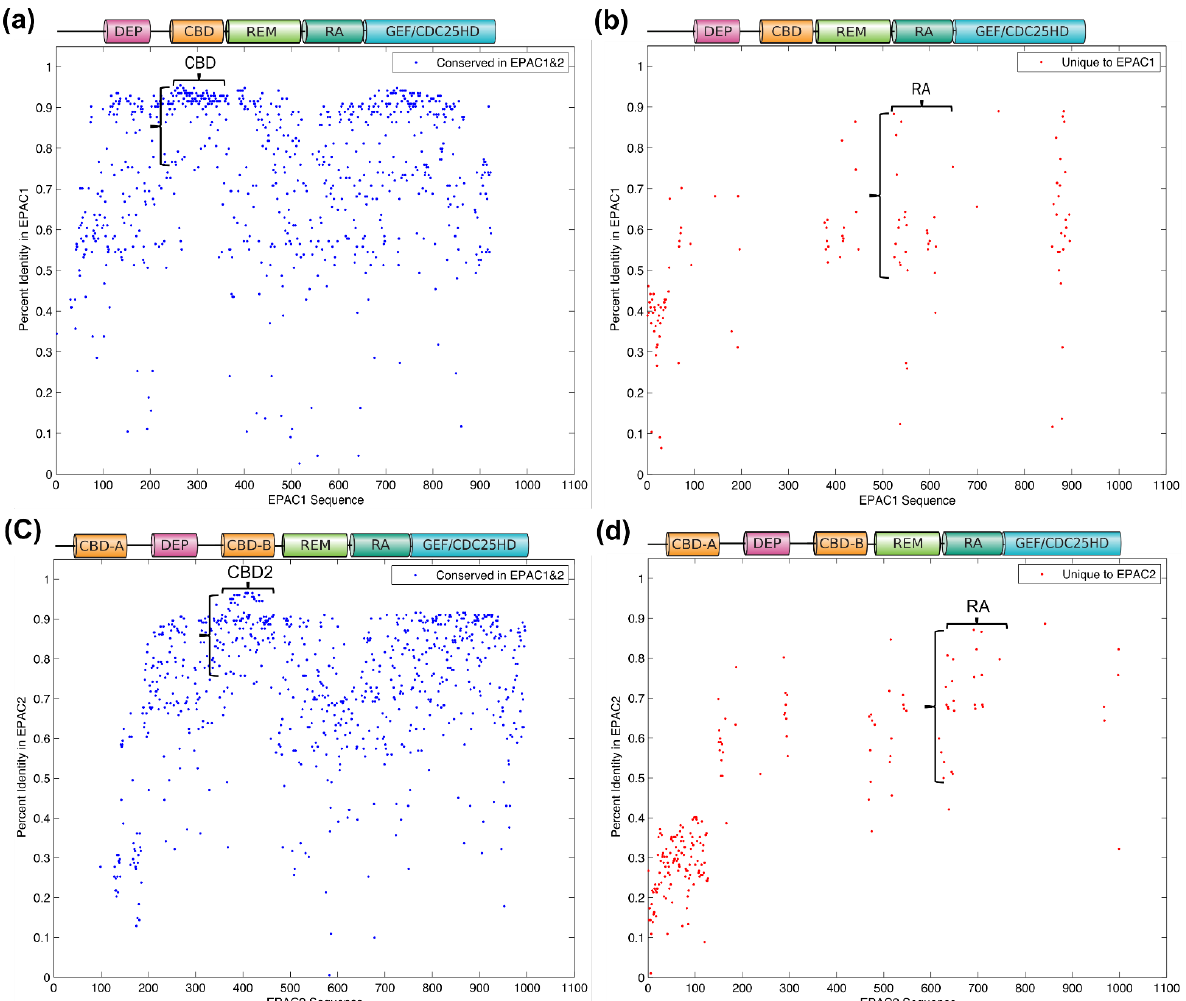
Figure 5. Sequence identity and diversity at individual residue between aligned human EPAC1 and EPAC2. ( a ) The percent identity of residues in EPAC1 over its entire range for the two EPACs. ( b ) Unique residues in aligned human EPACs in EPAC1. ( c ) The percent identity of residues in EPAC2 over its entire range for the two EPACs. ( d ) Unique residues in aligned human EPACs in EPAC2. The x-axes show amino acid residue numbers while the y-axes show percent identity of species in its own isoform.